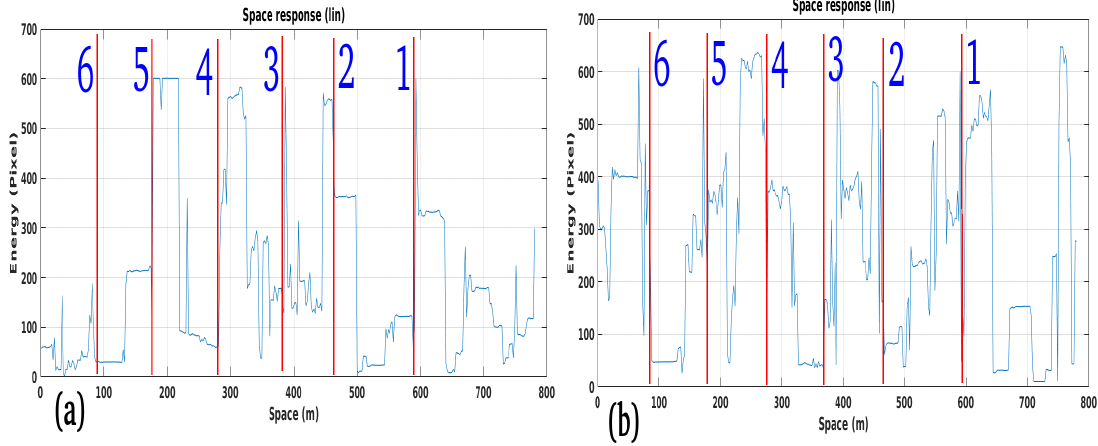
Figure 34. Longitudinal vibration trend versus space of the “Morandi” bridge: ( a ) temporal event 1, ( b ) temporal event